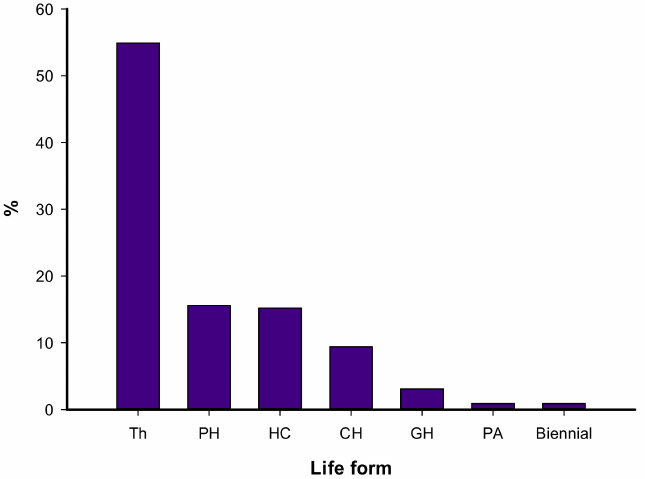
Figure 3. Lifeform spectrum of the recorded species in the study area. PH: Phanerophytes, CH: Chamaephytes, GH: Geophytes–Helophytes, HC: Hemicryptophytes, PA: Parasites, TH: Therophytes. The local geographical distribution indicated that 73.7% of the recorded species be- longed to the Mediterranean coast, followed by the Nile region (64.7%), Egyptian deserts (64.3%), Sinai (53.6%), and Oasis (46.0%) (Table S2). Regarding the global phytogeographi- cal distribution, the mono-regional elements were the highest (95 species = 42.4%), followed by bi-regionals (63 species = 28.1%), while the pluri-regional (49 species = 21.9%) and cos- mopolitans (15 species = 6.7%) were the lowest (Figure 4a). Thirty species (31.6%) of the mono-regionals were Saharo-Arabian, Mediterranean, and Tropical, which were repre- sented by 18 species (19.0% each) and 14 species (14.7%), which were Sudano-Zambezian elements. In general, regarding either mono-, bi-, or multi-regional elements, 126 species belonged to Mediterranean, 78 to Irano-Turanian, 59 to Saharo-Arabian, and 42 to European elements (Figure 4b). It is worth noting that two endemic species were recorded in the studied urban habitat, namely Sinapis allionii and Sonchus macrocarpus